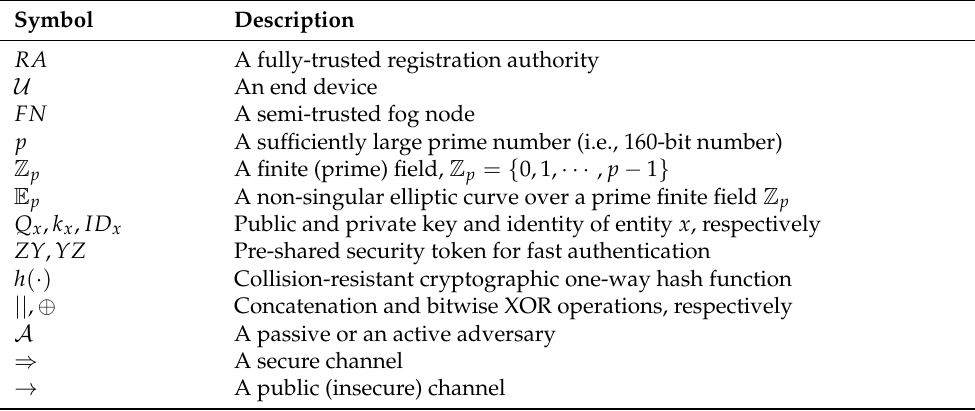
Table 1. Important notations and their